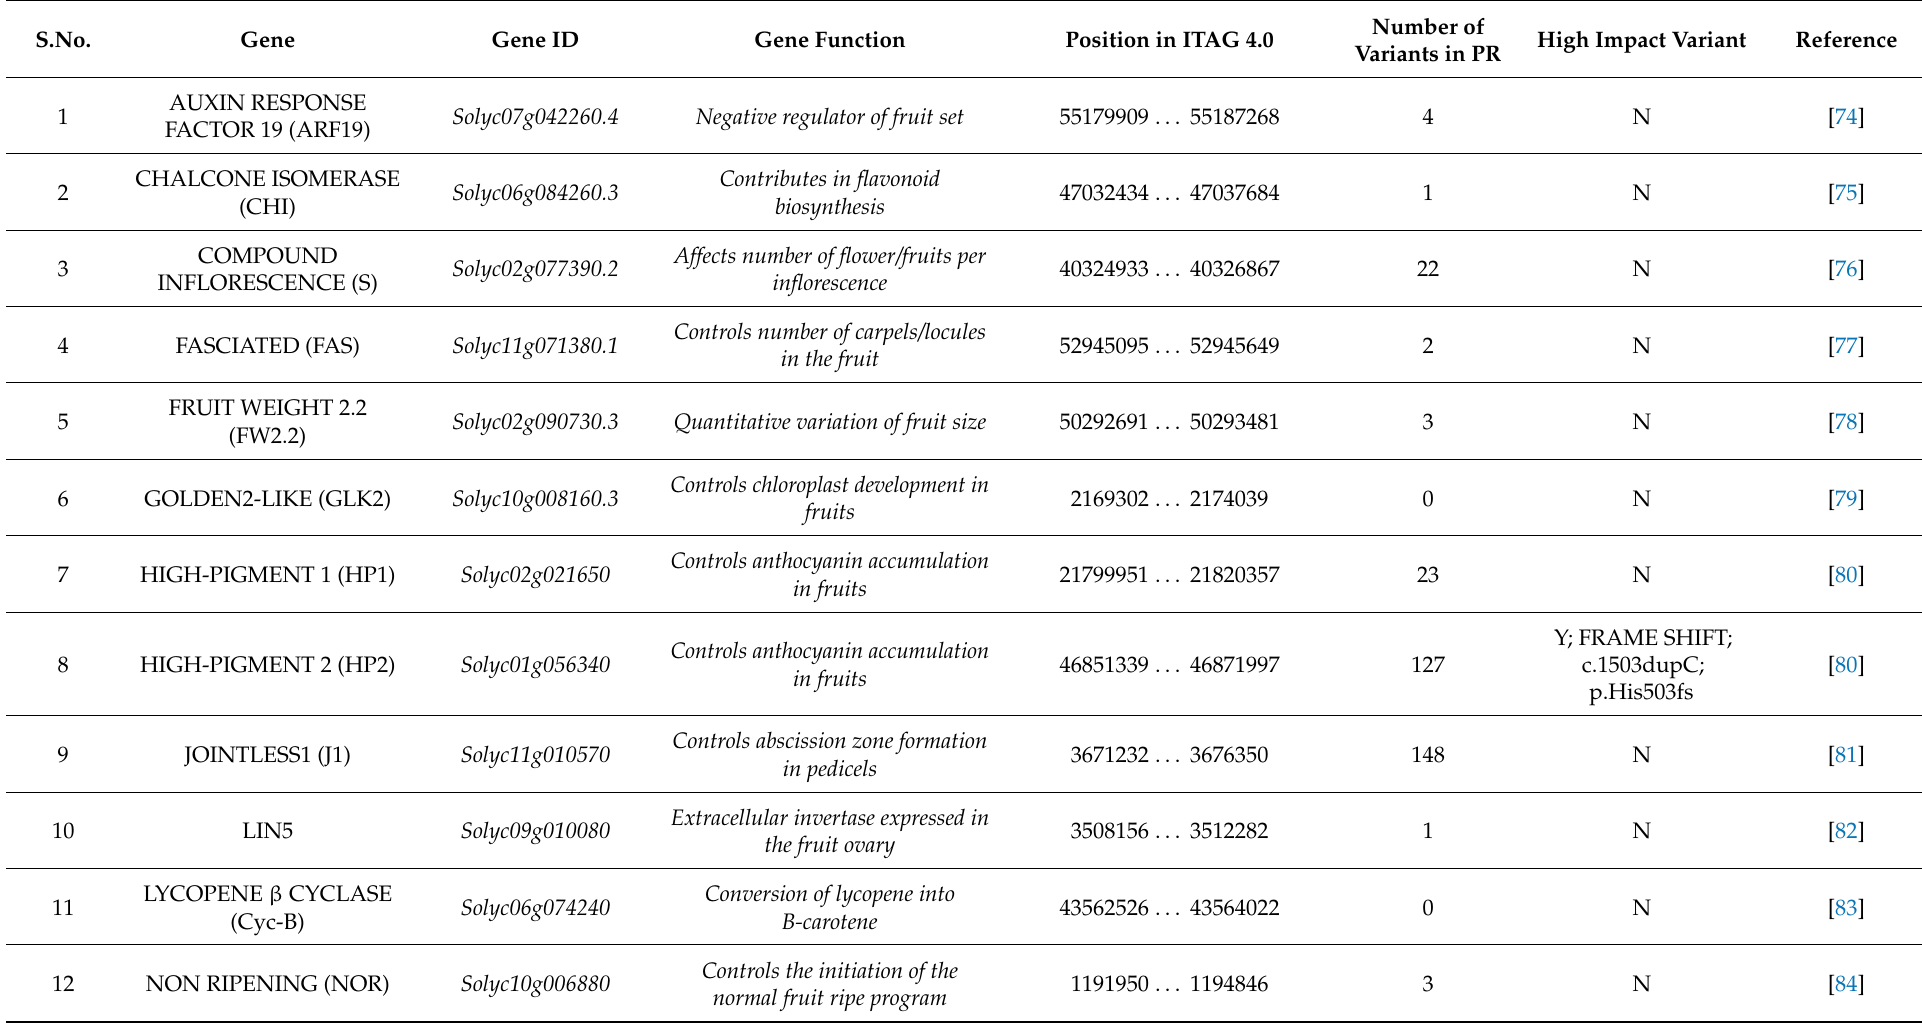
Table 5. Allele mining of genes involved in fruit quality regulation in S. lycopersicum cv. Pusa